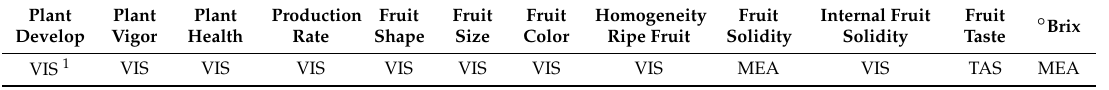
Table 6. Parameters choose to evaluate the single selected